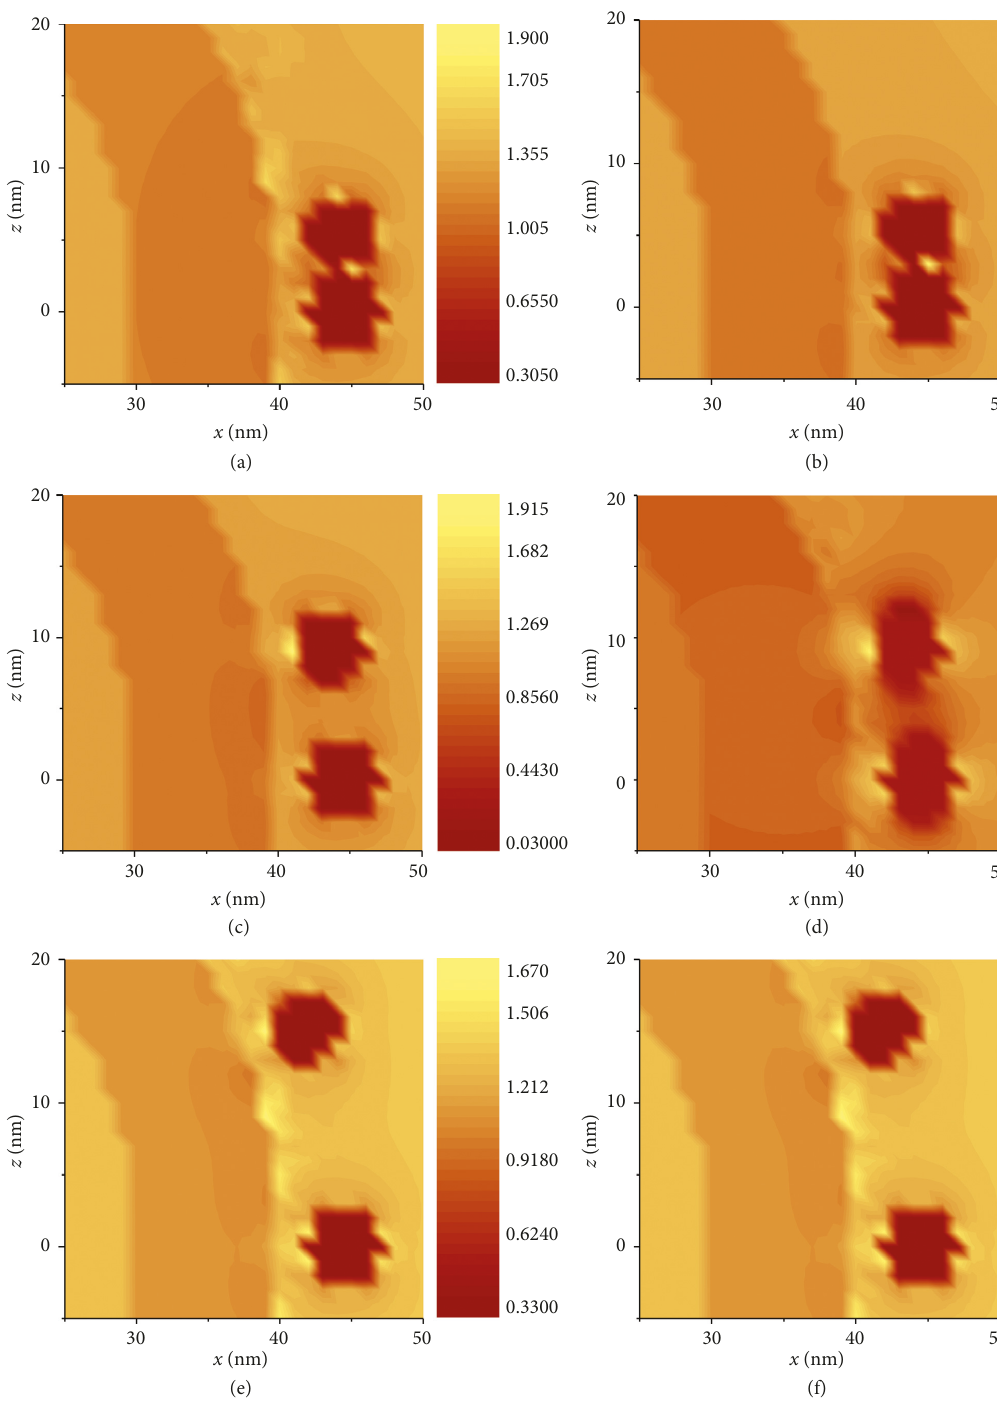
Figure 4: Local field distribution in the system of three nanoparticles in Figure 2. The big nanoparticle is of 30nm inner radius and has the shell of 10nm thickness with an inner dielectric constant value ε 5nm radius without the shell for α � 7 ° (a, b), α � 12 ° (c, d), and α � 20 ° (e, f). (a, c, e) Taking into account the nanoparticles interaction; (b, d, f) without taking into account the nanoparticles